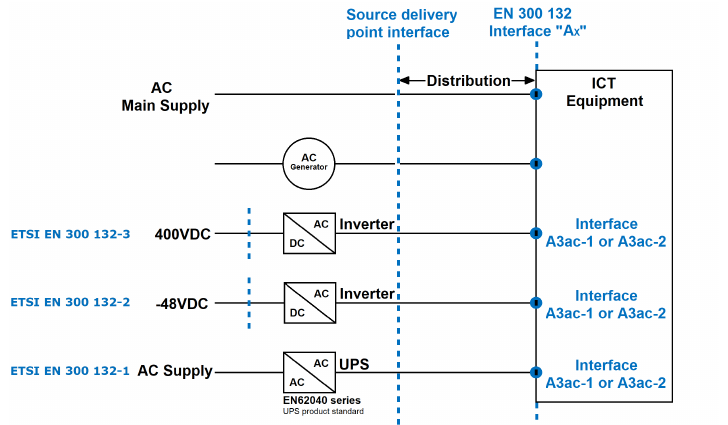
Figure 1. General identification of the interfaces in ETSI EN 300 132